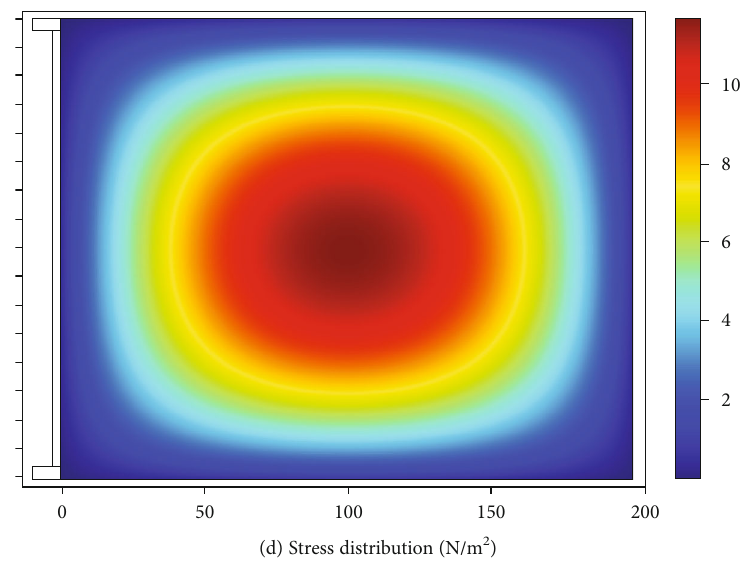
Figure 6: Distribution of seepage parameters at z = 1 : 5m of goaf fl